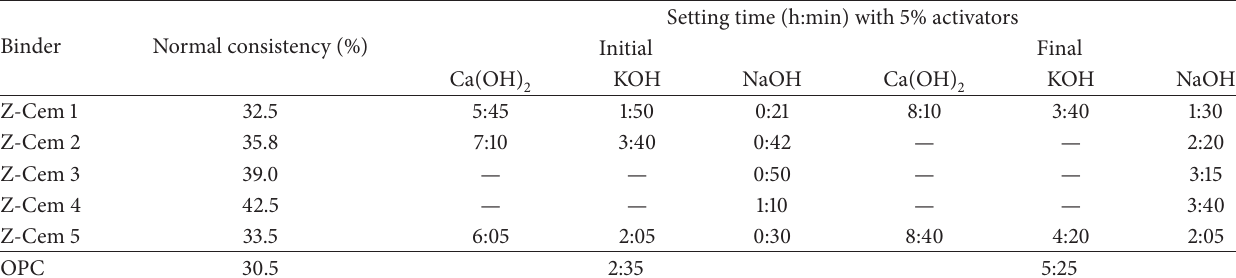
Table 4: Consistency and setting time of Z-Cem and OPC.